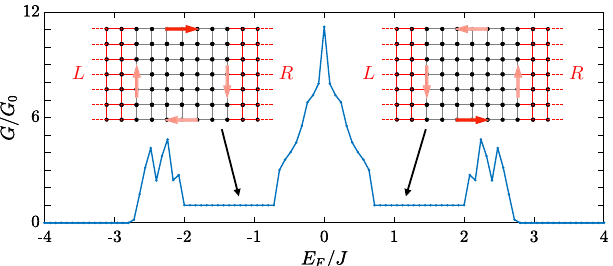
FIG. 2. (Insets) Example of a two-terminal setup with a square lattice geometry of N x ¼ N y ¼ 7 sites along the x and y directions, respectively. The inner system is represented by the black dots, while the red dots identify the sites of the left ( L ) and right ( R ) reservoir. The arrows describe the motion of the chiral edge modes present in the model (clockwise at energies E < 0 and counterclockwise at E > 0 ). (Main) Conductance G L;R of the Harper-Hofstadter model with magnetic flux φ ¼ 2 π = 3 , within the wideband approximation (see Appendix A), for an input bias applied to the left reservoir; the system size is N x ¼ N y ¼ 30 . The plateaus are associated with the edge modes illustrated in the